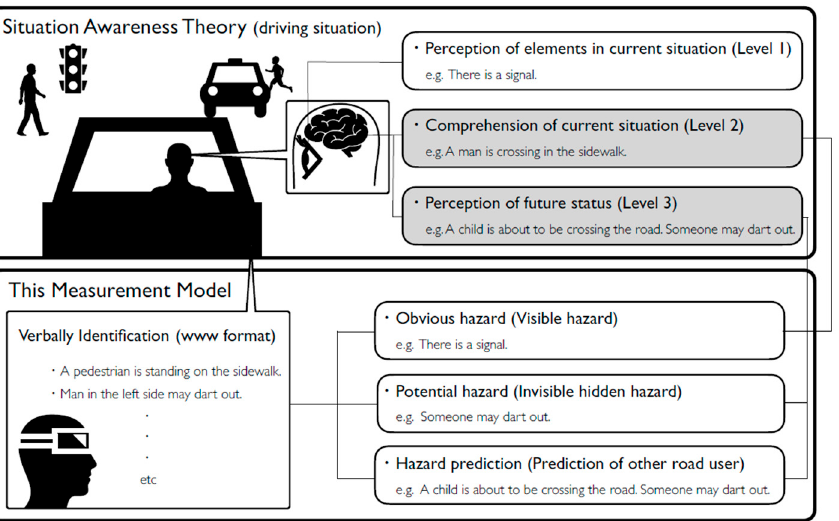
Figure 1. Situation Awareness Theory and measurement model in this study.